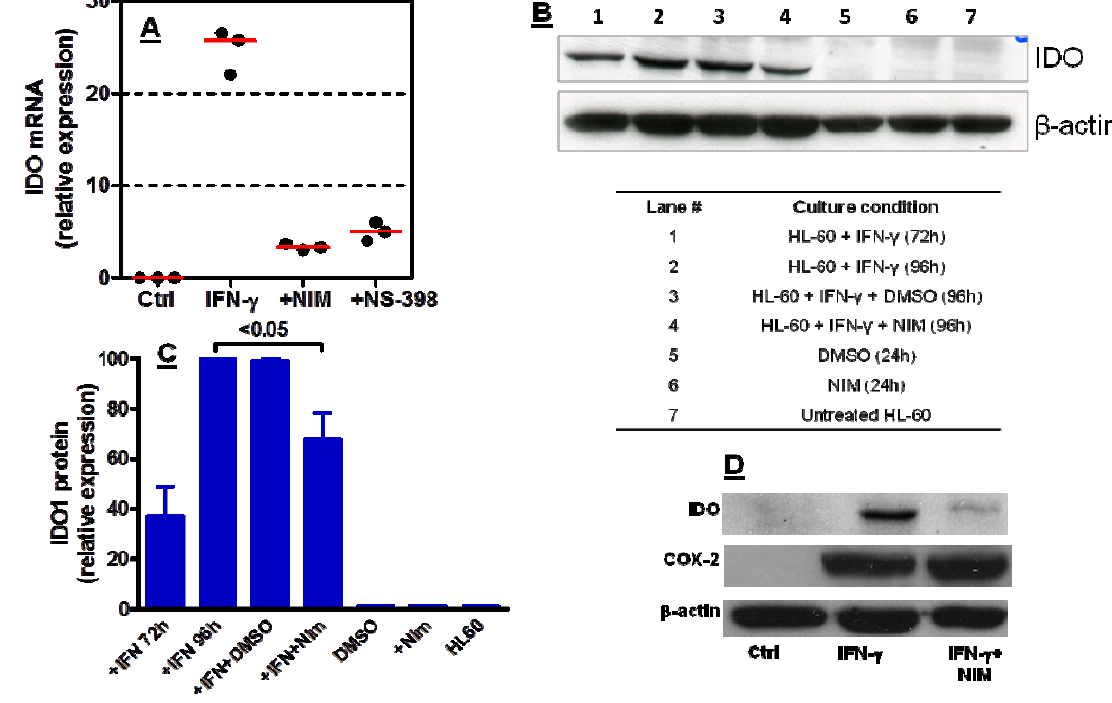
Figure 3. Modulation of IDO1 mRNA and protein by COX-2 inhibitors. Leukaemia cells were stimulated with 100 ng/mL IFN- γ for 72 h, followed by the exposure to COX-2 inhibitors for 24 h. Panel A: IDO mRNA expression by leukaemia HL-60 cells as assessed with quantitative RT-PCR. Panel B: IDO protein expression by leukaemia HL-60 cells in a representative experiment out of five with similar results. Panel C: Densitometry of western blot runs; bars depict the mean and SEM from five independent experiments. Culture conditions and lane numbers for the experiments shown in panels B and C are detailed at the bottom of panel B. Panel D: COX-2 and IDO protein expression by leukaemia HL-60 cells that were stimulated with IFN- γ and then treated with nimesulide for 24 h. A representative experiment out of 3 with similar results is